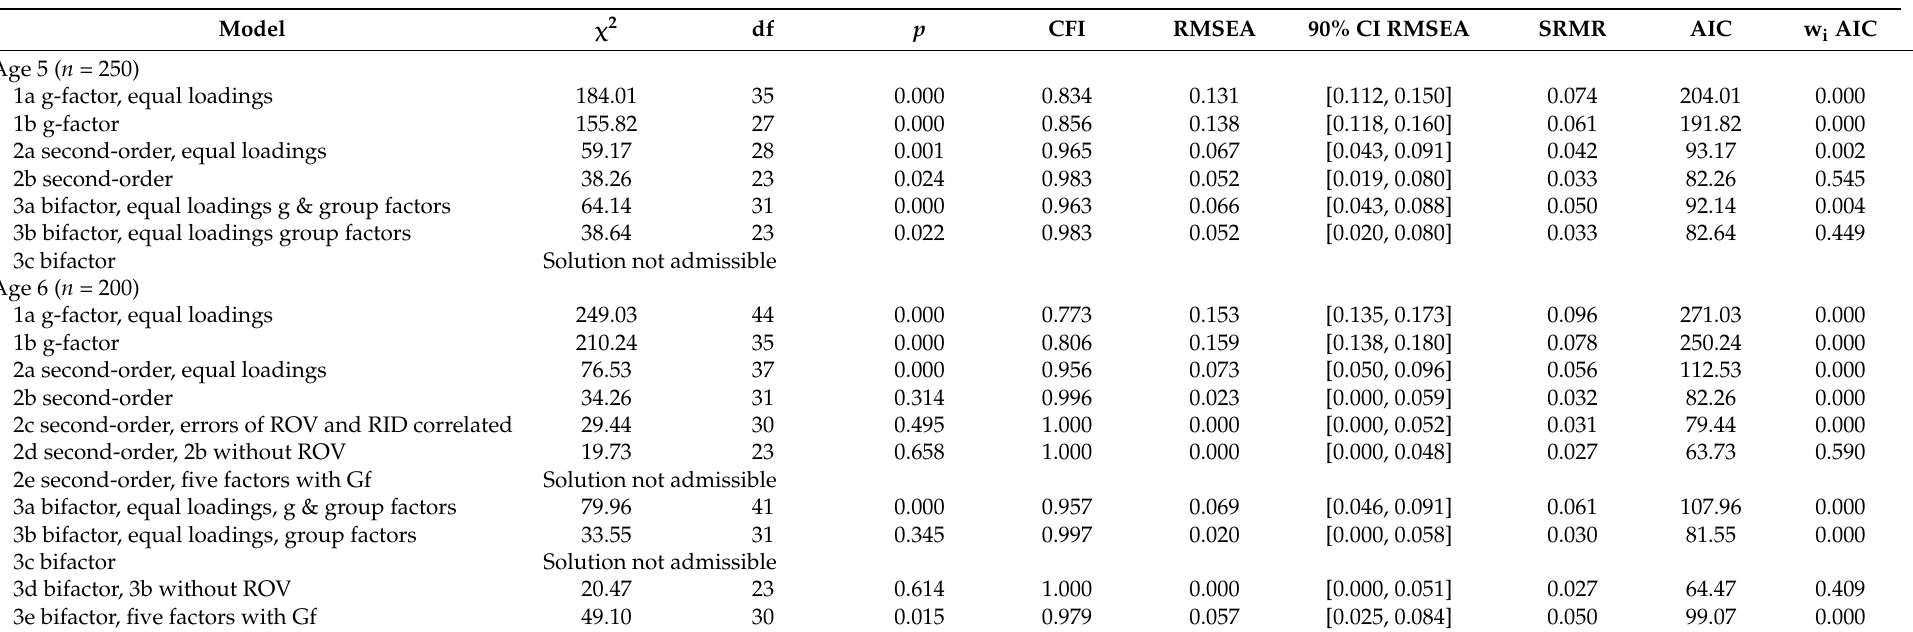
Table 5. Confirmatory factor analysis fit statistics for KABC-II core subtest CHC